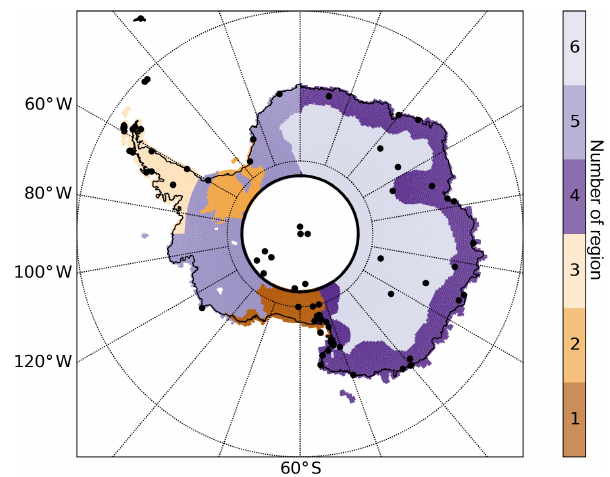
Figure 1. Map of the studied regions on the ERA5 grid. Numbers refer to the regions defined in Table B1. Black dots indicate SCAR READER temperature measurement stations (AWS and manned stations). The black line indicates the 82 ◦ S latitude